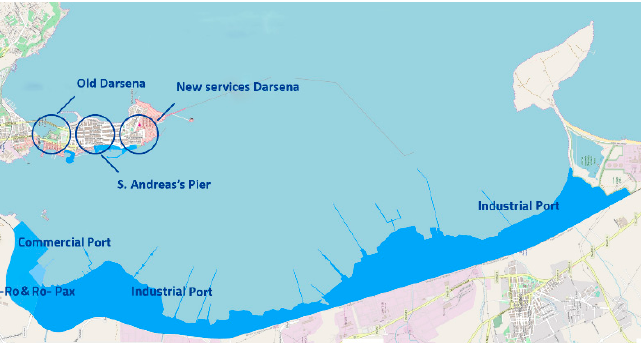
Table 1. Port of Augusta container terminal characteristics.